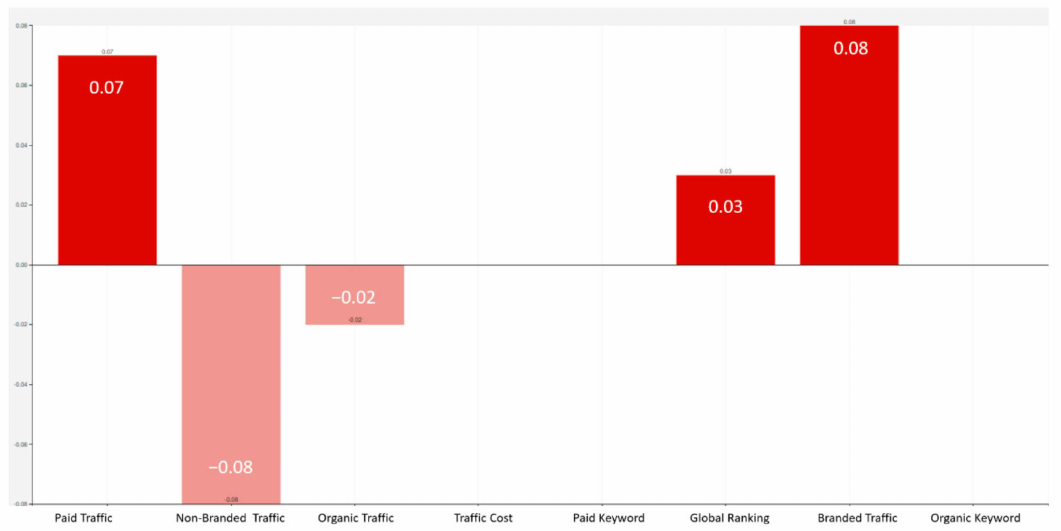
Figure 5. Scenario 1 results (COVID-19 cases at 0.9).